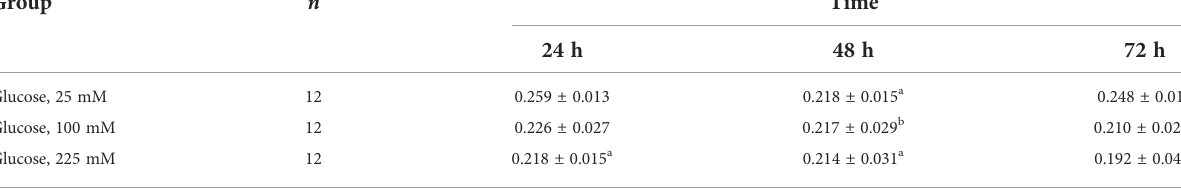
TABLE 3 Effects of different times and concentrations of glucose medium on the viability of hippocampal neurons. Group